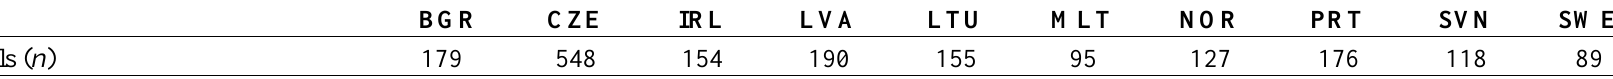
Table 1. Frequency of 18 school nutrition and physical activity environment characteristics included in the mandatory COSI school form in round 1 (2007/2008), by country *